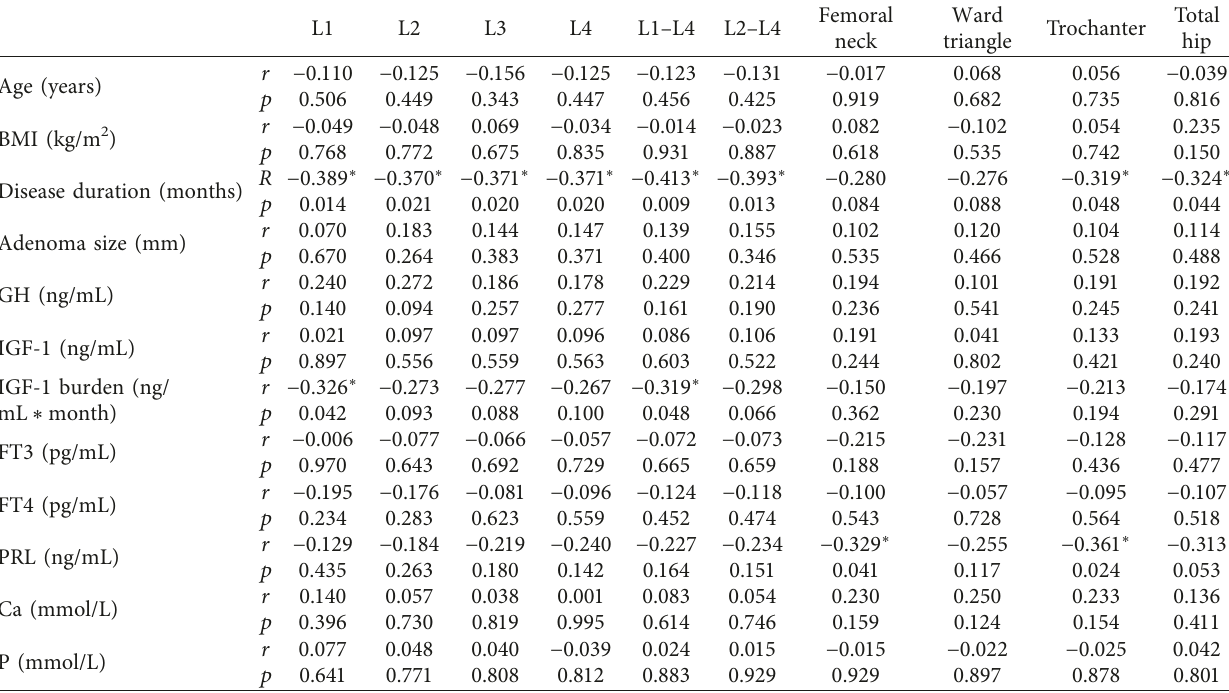
Table 4: Correlation analysis of clinical data and the BMD Z